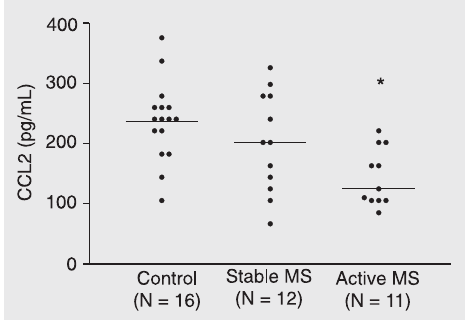
Figure 2. CCL2 levels in cere- brospinal fluid (CSF) from pa- tients with active multiple sclero- sis (MS; N = 11), stable MS (N = 12) and control subjects (N = 16). *P < 0.05 compared to con- trol (Newman-Keuls multiple comparison